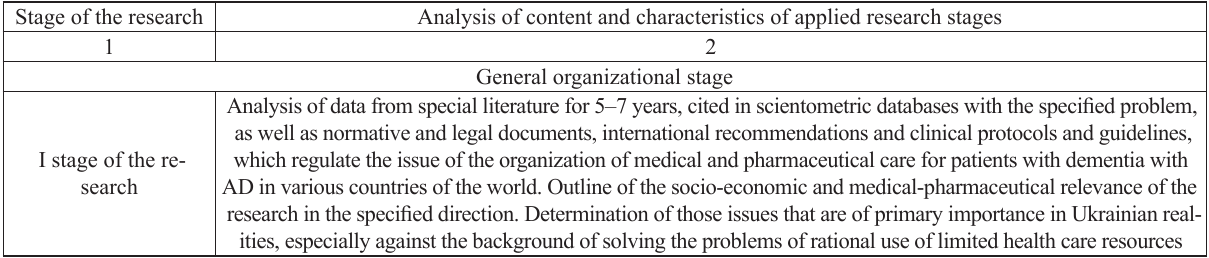
Characteristics and content of the main stages of research Stage of the research Analysis of content and characteristics of applied research